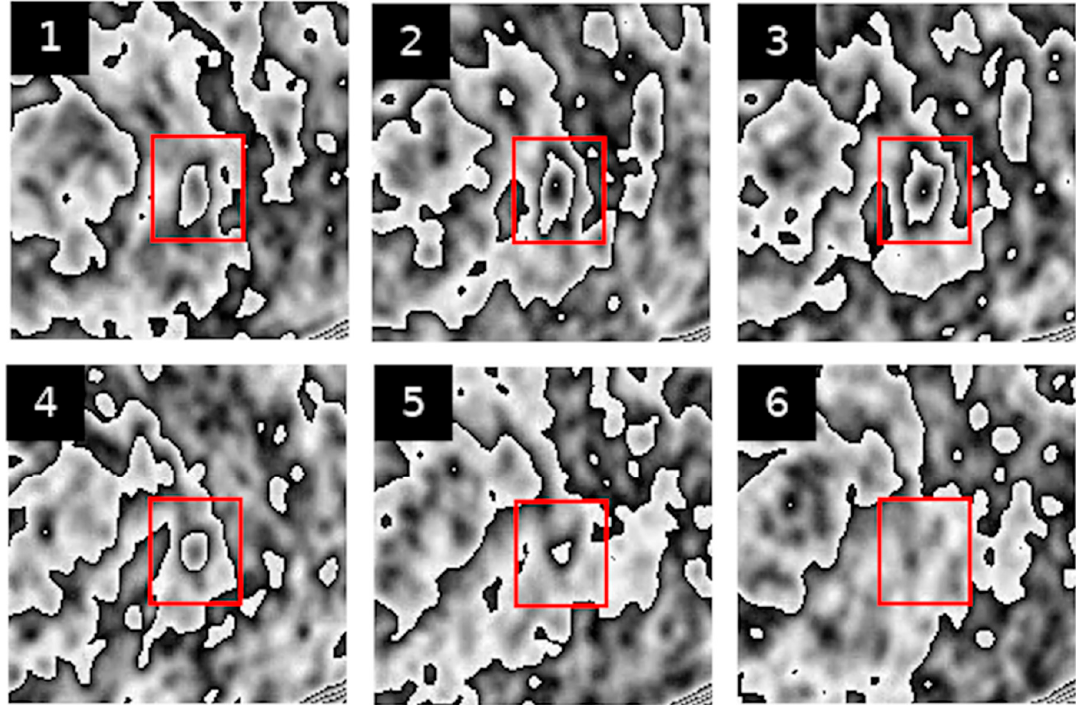
Figure 3. Result of the transformation of PET image sequences using the PCUL-FDG method. The red square indicates the site of a benign hypermetabolic pulmonary nodule (Figures 1–6 show successive slices of a lung nodule).